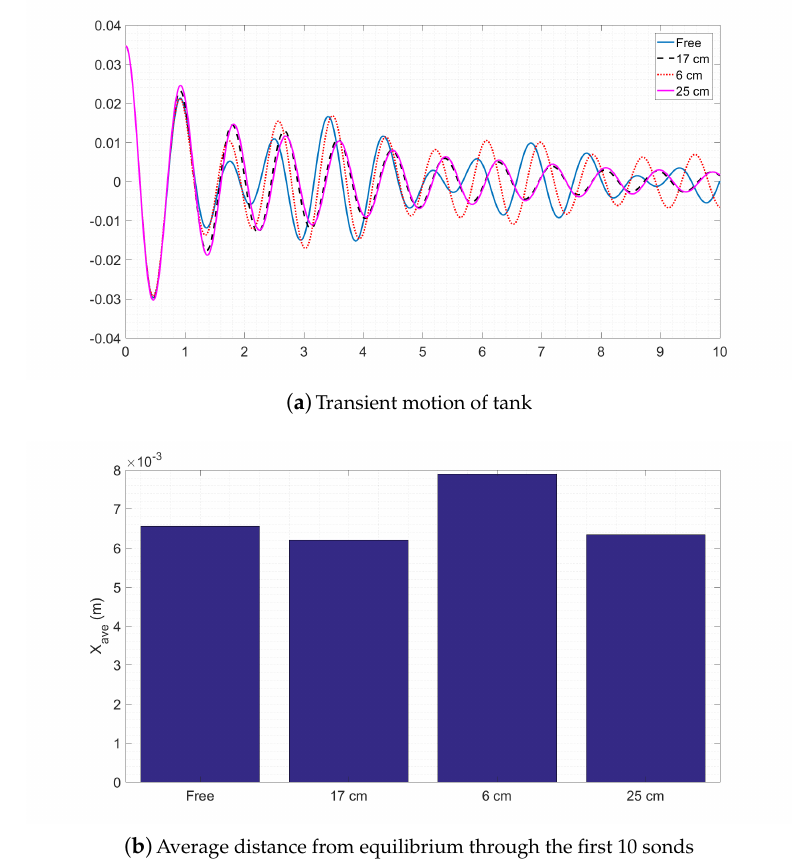
Figure 12. Time histories and average solid displacement of different side gaps between baffles and